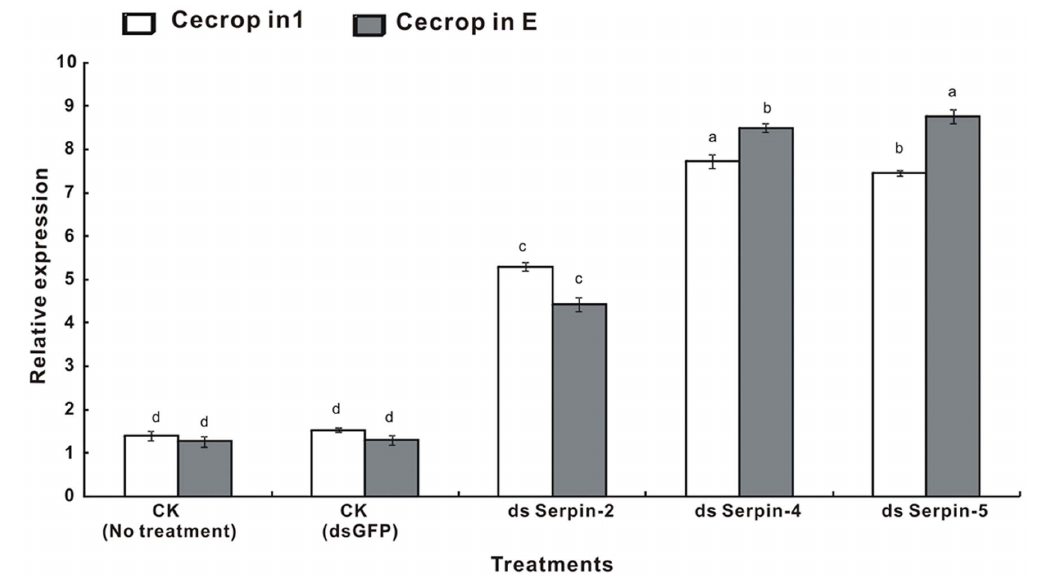
Figure 9. Expression of antimicrobial peptides (cecropin1 and cecropinE) after RNAi detected by SYBR Green real-time PCR. b -actin gene was used as an internal control to calibrate the cDNA template for all the sample. Each value was shown as values 6 S.E.M of three independent experiments. Significant differences were indicated with different letters at P , 0.05.